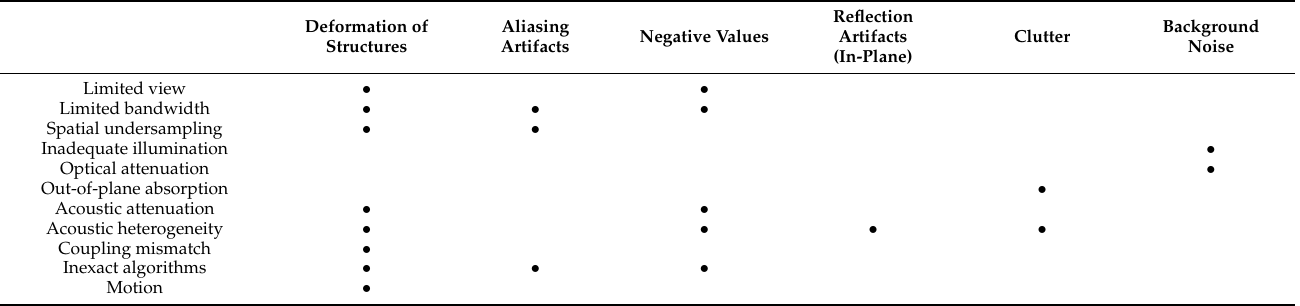
Table 1. An overview describing the correspondence between primary limiting factors and their manifestations in the image domain. The bullet points ( • ) indicate correspondence between the limiting factors (table rows), and manifestations (table